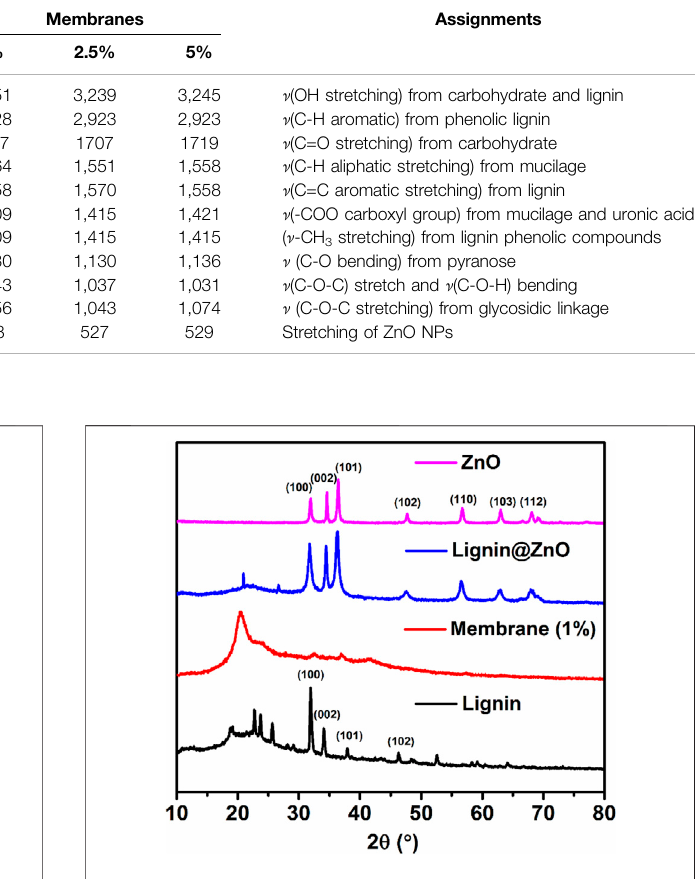
and fabricated membrane